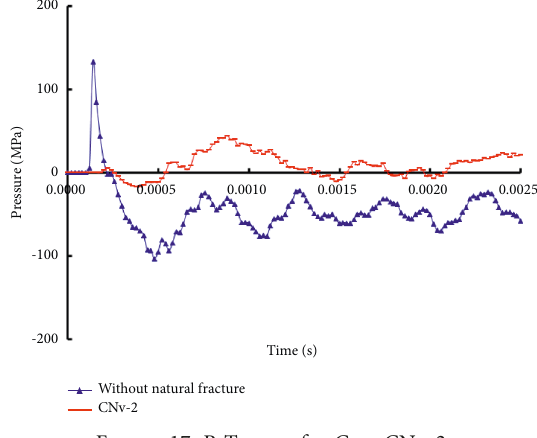
Figure 16: P-T curve for Case CN